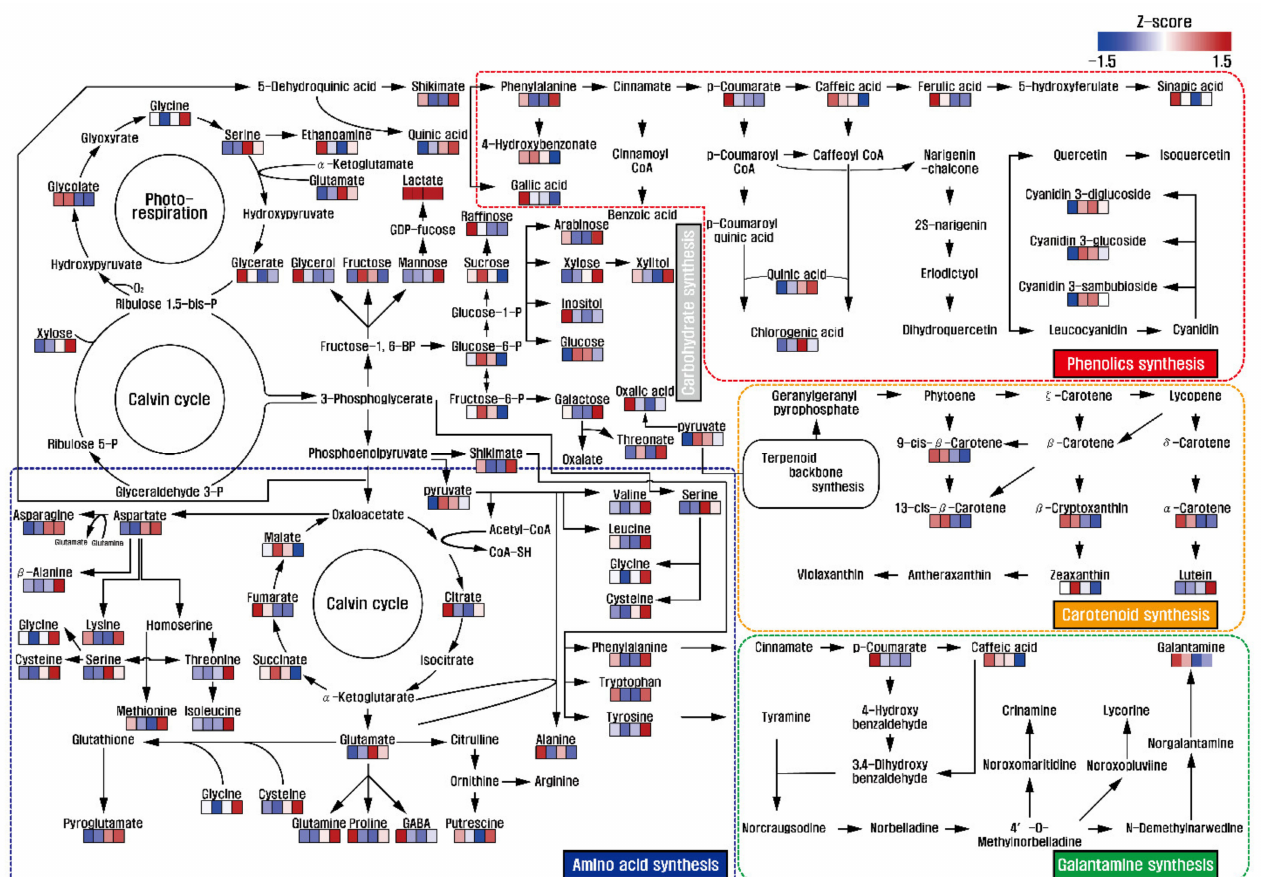
Figure 2. Overview of metabolic changes in different developmental stages of L . radiata flowers. The scale bar indicates the z-score transformed average values of metabolites, and the colored squares (blue-to-red) represent relative metabolite abundance in the different flower developmental